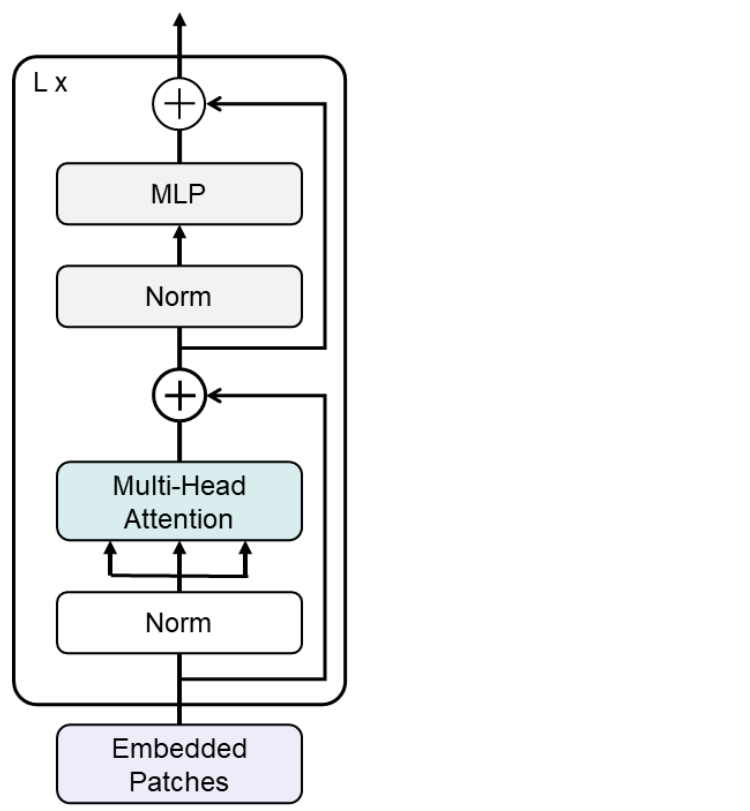
Figure 5. The architecture of the